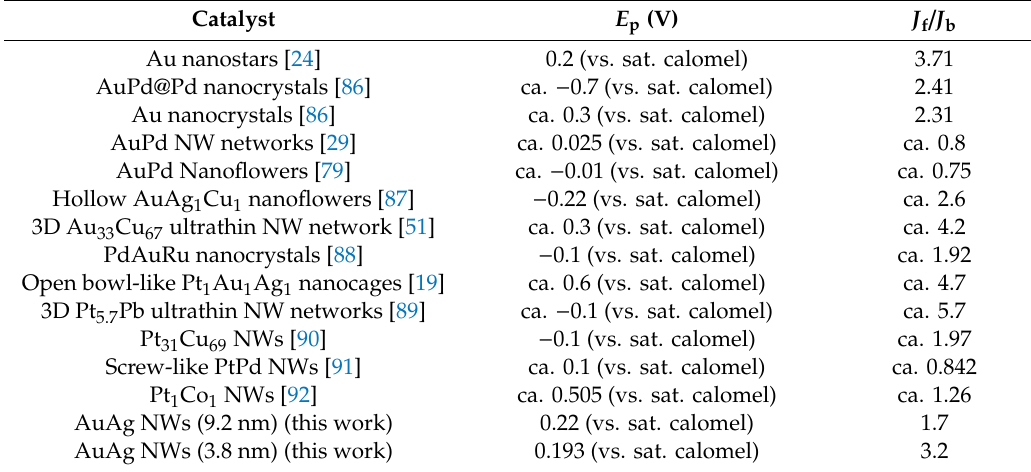
Table 1. Electro-oxidation parameters of EG by various noble metal-based catalysts in an alkaline medium.